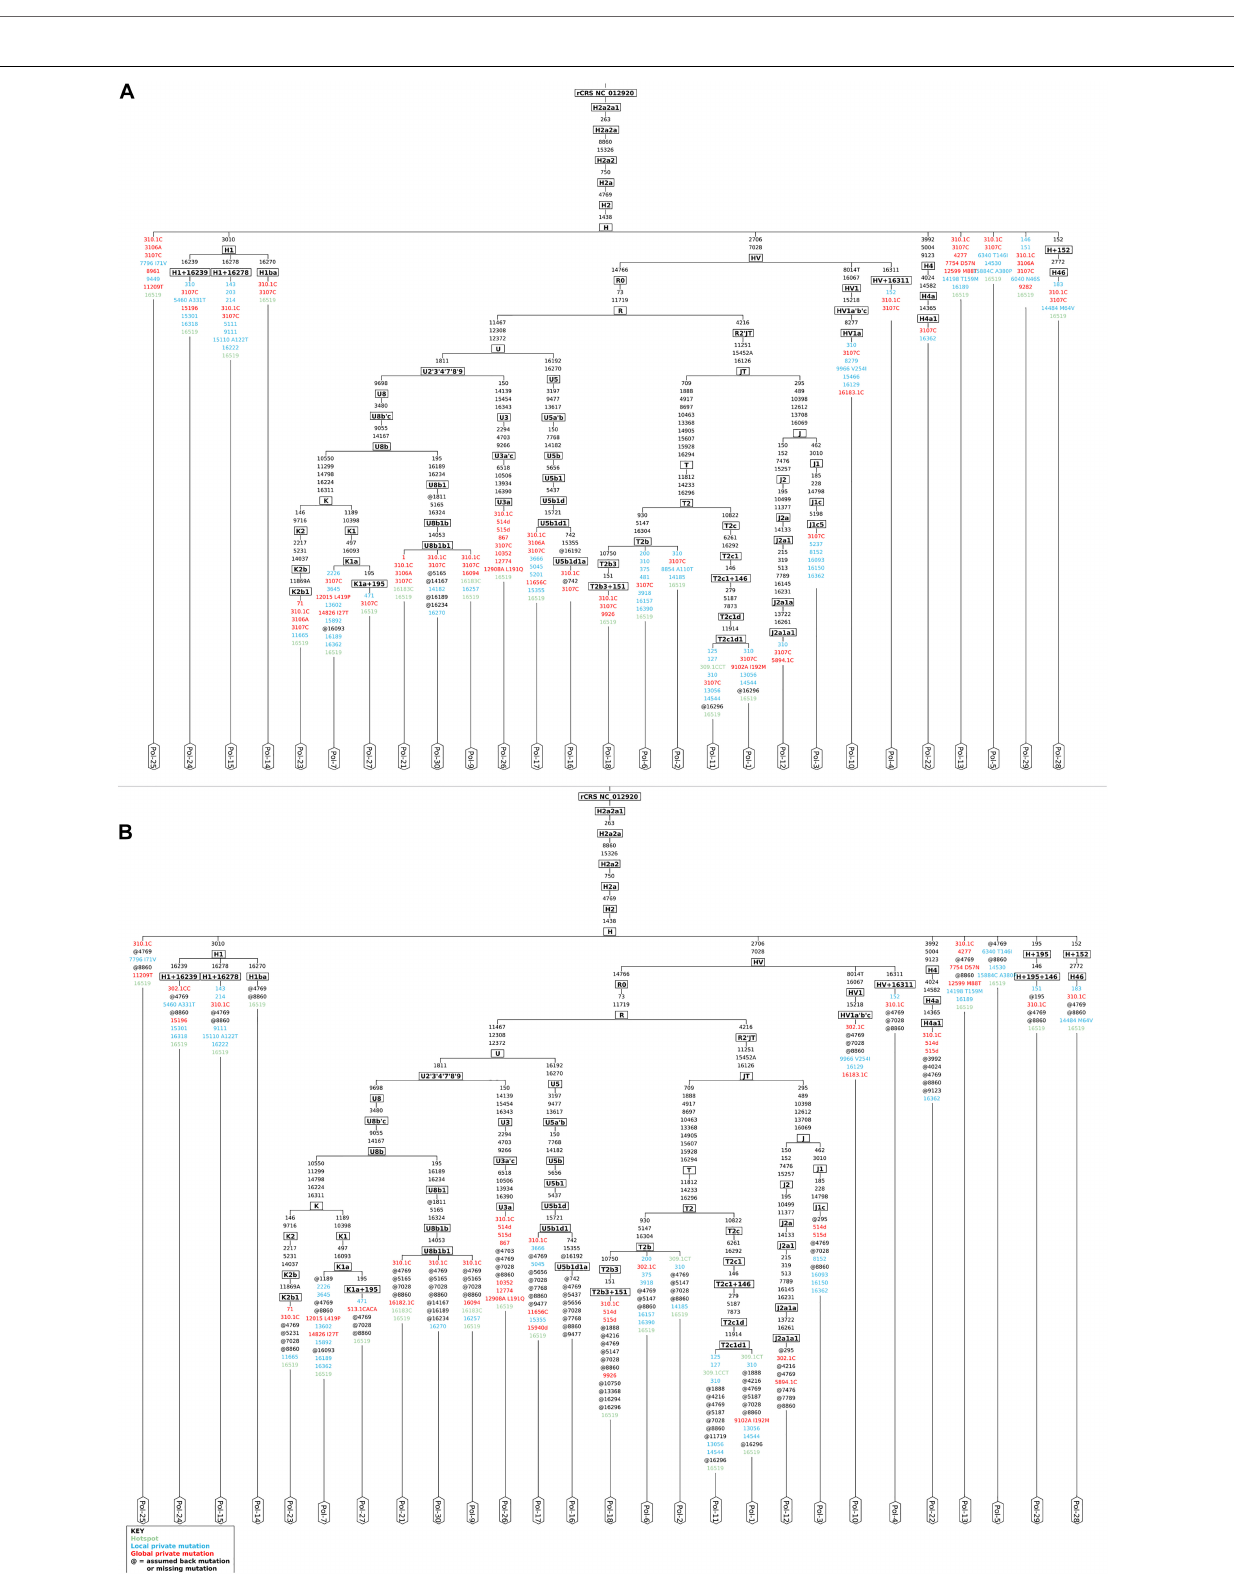
Frontiers in Genetics |